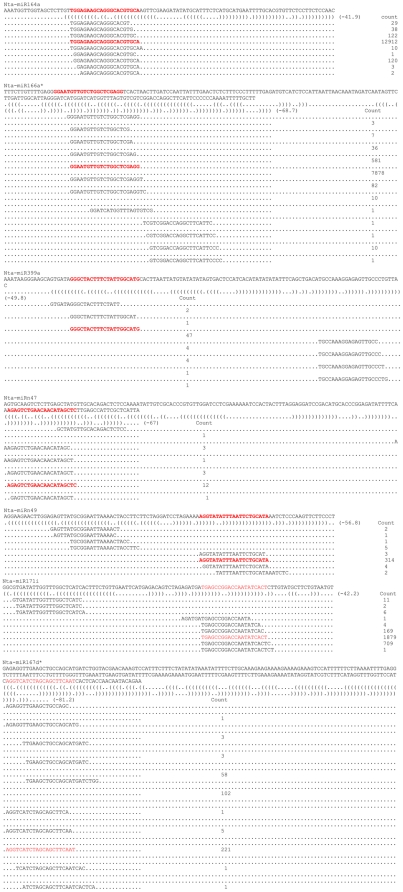
MiRNA precursors and the sequencing reads of miRNA.(Nucleotide bases of mature miRNAs are highlighted with red color.).